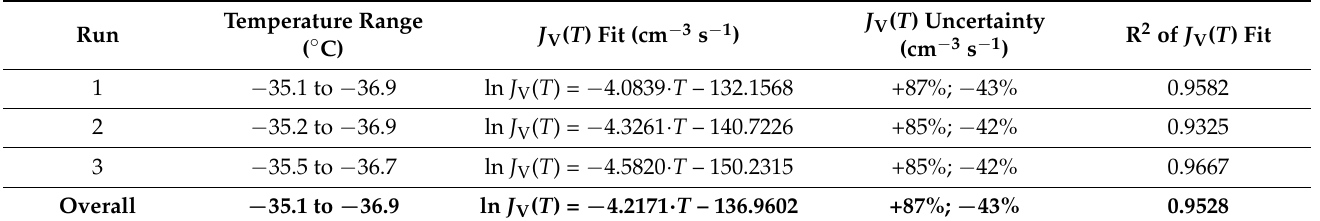
Table 2. Parameterisations of the volume homogeneous ice nucleation rate coefficient, J V ( T ), for each of the three experi- mental runs, and the overall parameterisation for all of the